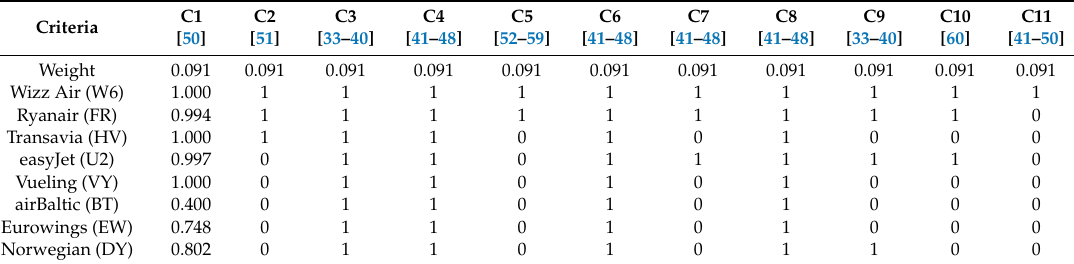
Table 2. Input for TOPSIS LCC criteria. Source: compiled by the authors.